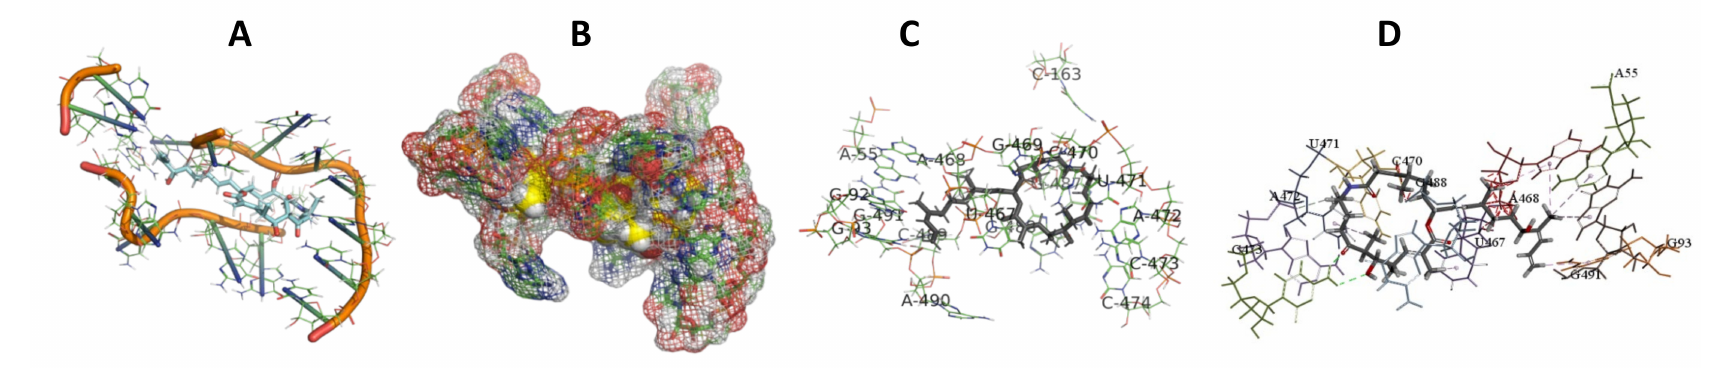
Figure 4. T. Brucei bound to Angiolam. ( A ): Best binding pose and nucleotides involved. ( B ): Schematic binding pocket. ( C ): shows the Nucleotides component that re involved in binding. ( D ): Shows the main bonds involved between the compound and the nucleotide component.